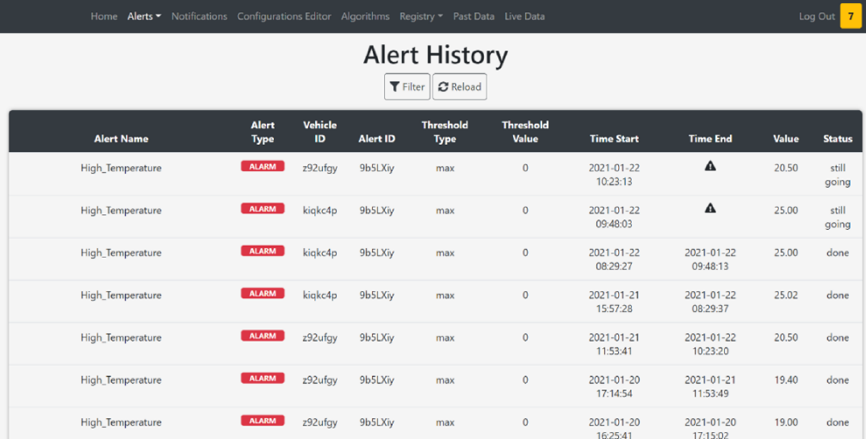
Figure 10. Alert table in server page.